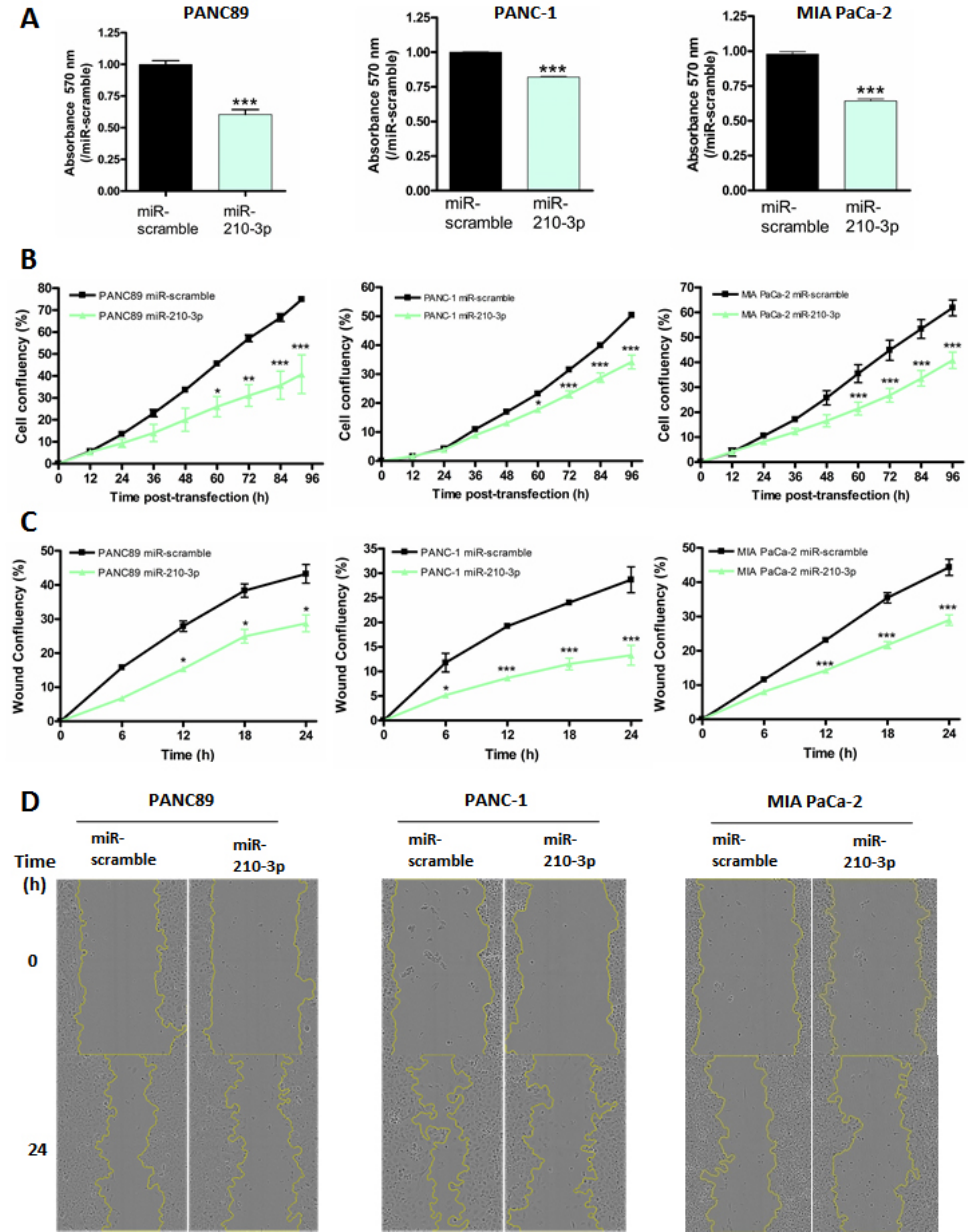
Figure 5. Transient expression of miR-210-3p inhibits proliferation and migration of pancreatic cancer cells. ( A ) PANC89, PANC-1 and MIA PaCa-2 cells were transiently transfected with miR-210-3p or miR-scramble for 96 h. Cell viability was assessed using MTT assays. MiR-scramble condition was arbitrarily set to 1. Three independent experiments were performed. ( B ) Cell confluency was evaluated using the Incucyte™ apparatus over 96 h following miR-210-3p or miR-scramble transient transfection of PANC89, PANC-1 and MIA PaCa-2 cells. Three independent experiments were performed. ( C ) Wound-healing assays were performed in transient transfected miR-210-3p or miR-scramble cells. Wound area was measured every 6 h for 24 h using an Incucyte™ instrument. Experiments were performed in triplicate. * p < 0.05, ** p < 0.01 and *** p < 0.001 indicate statistical significance compared to miR-scramble. Three independent experiments were performed. ( D ) Representative images of wound healing in PANC89, PANC-1 and MIA PaCa-2 cells.